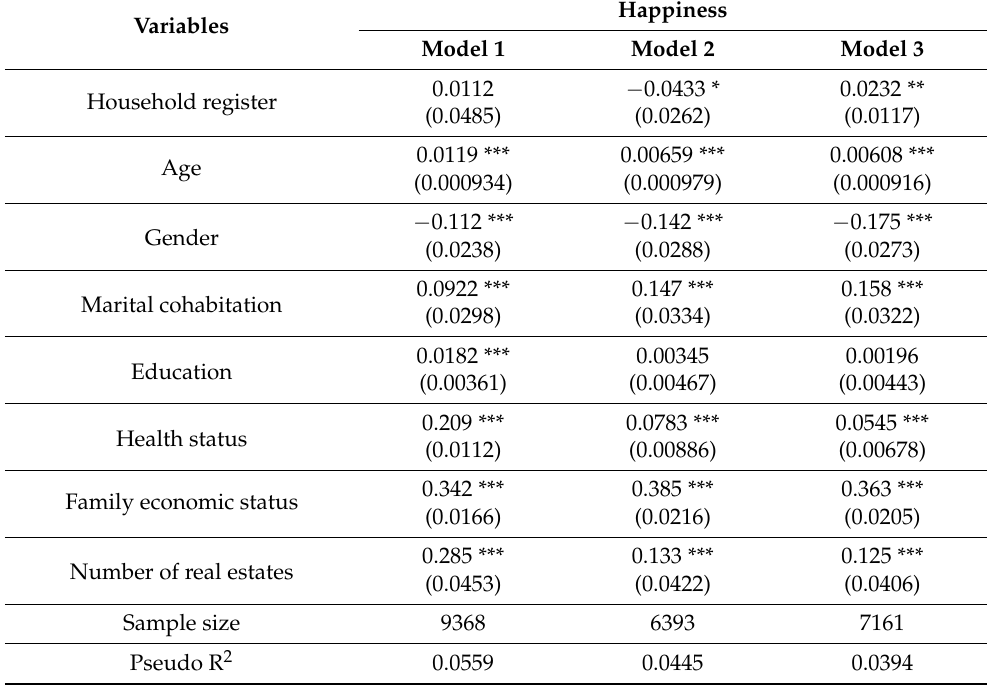
Table 3. Comparison of happiness among multiple